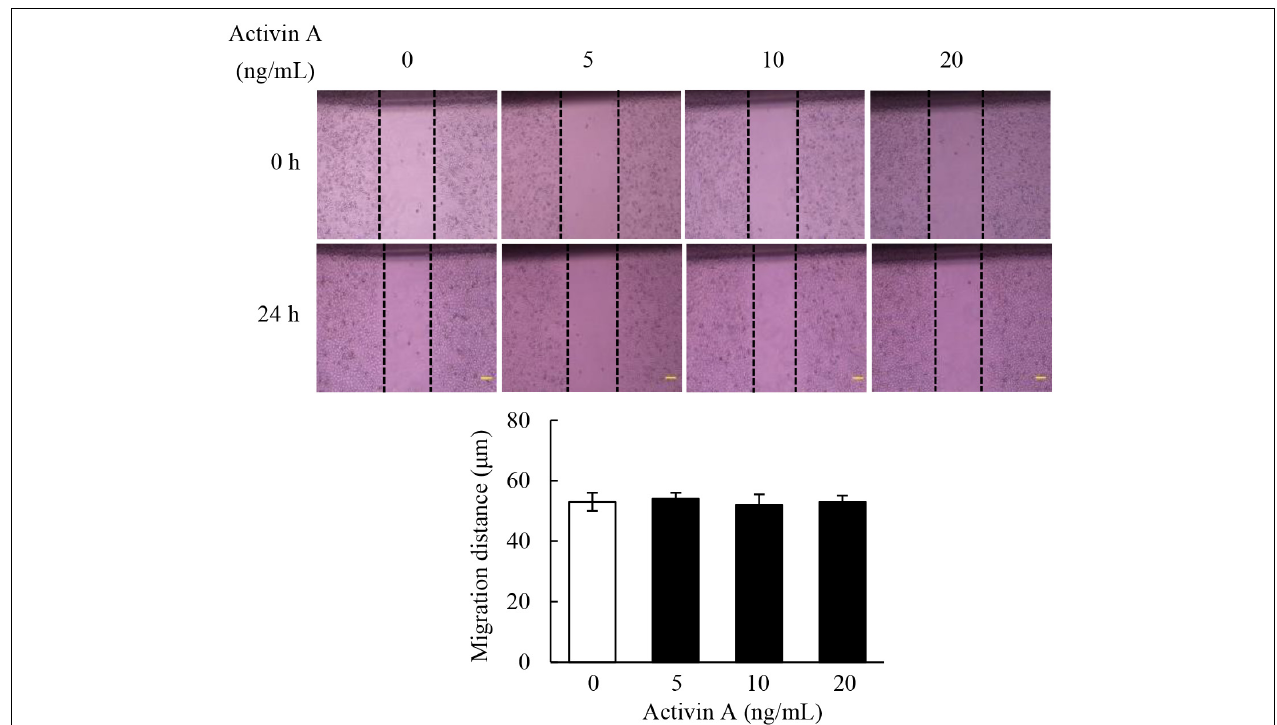
FIGURE 3 | Effects of activin A on wound healing in L929 cells. A scratch-wound was generated in monolayer L929 cells, and then cells were treated with activin A (0–20 ng/mL) for 24 h. The graph showed the degree of wound healing from three separate experiments. Scale bar = 100 µ m.